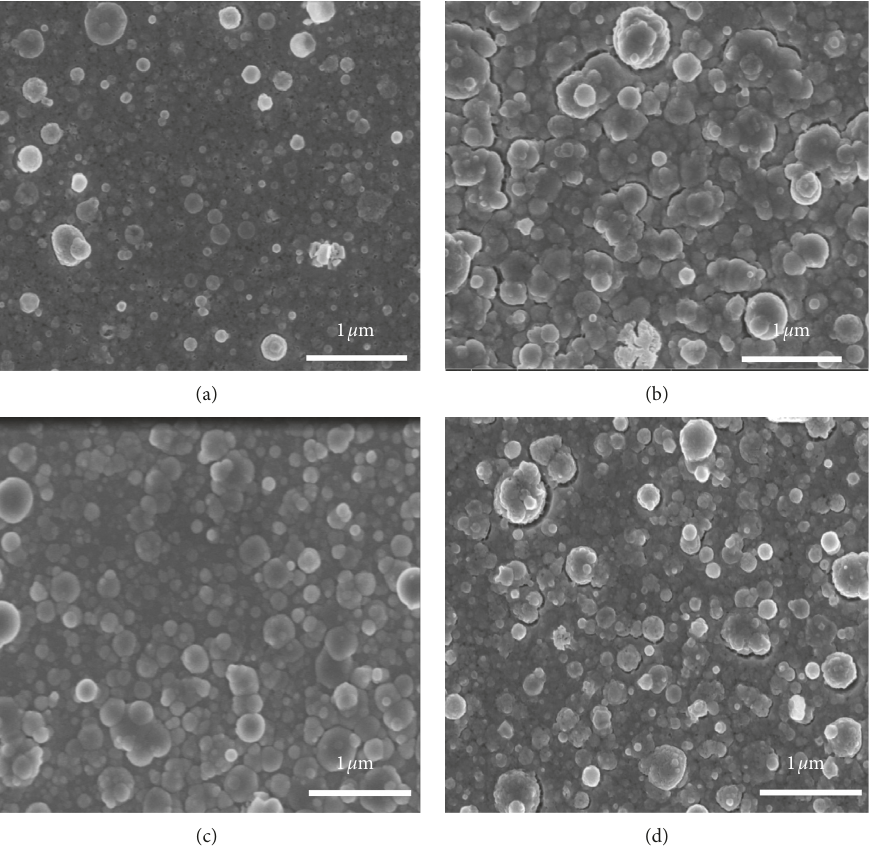
Figure 9: SEM image of LaMnO 3 thin films with different O 2 flux at (a) 0, (b) 5, (c) 15, and (d) 25 sccm after annealing at 800